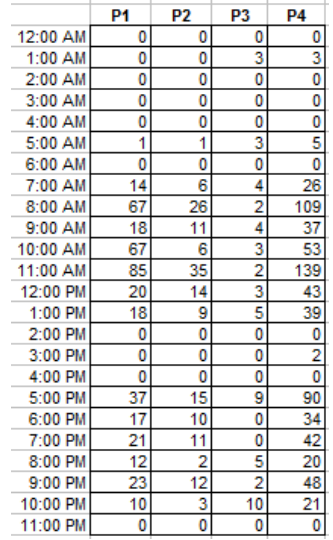
Figure 7. The synthetic activity data for one day after the preprocessing phase.